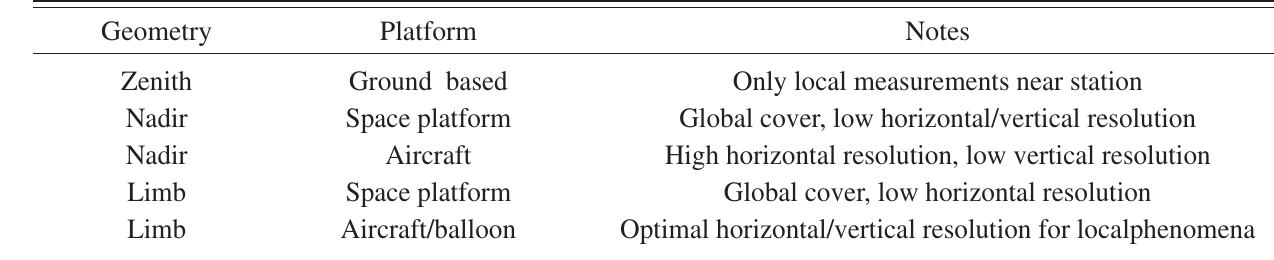
Table I. Comparison between different observing platforms and geometries.